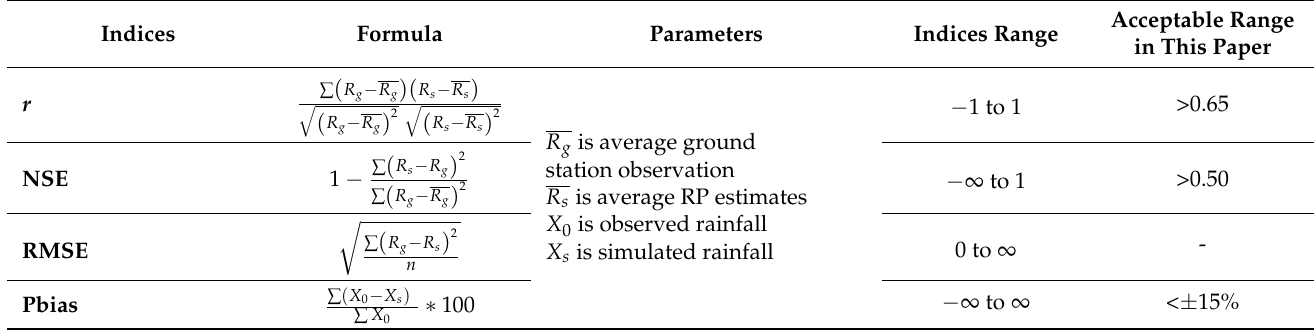
Table 2. Mathematical descriptions of the applied statistical